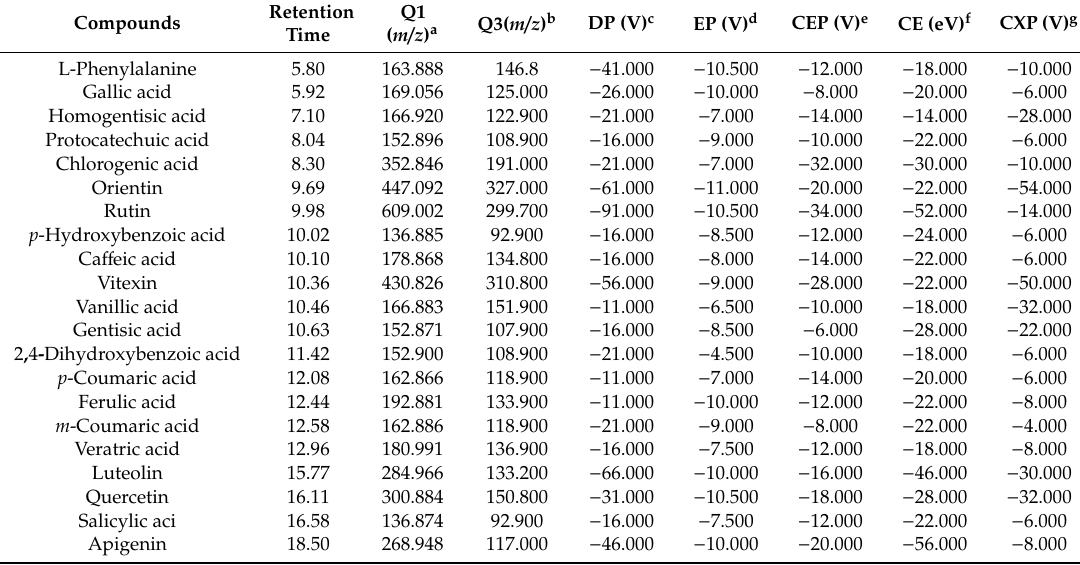
Table 1. LC-MS / MS parameters for the quantitative analysis of 22 phenolic compound